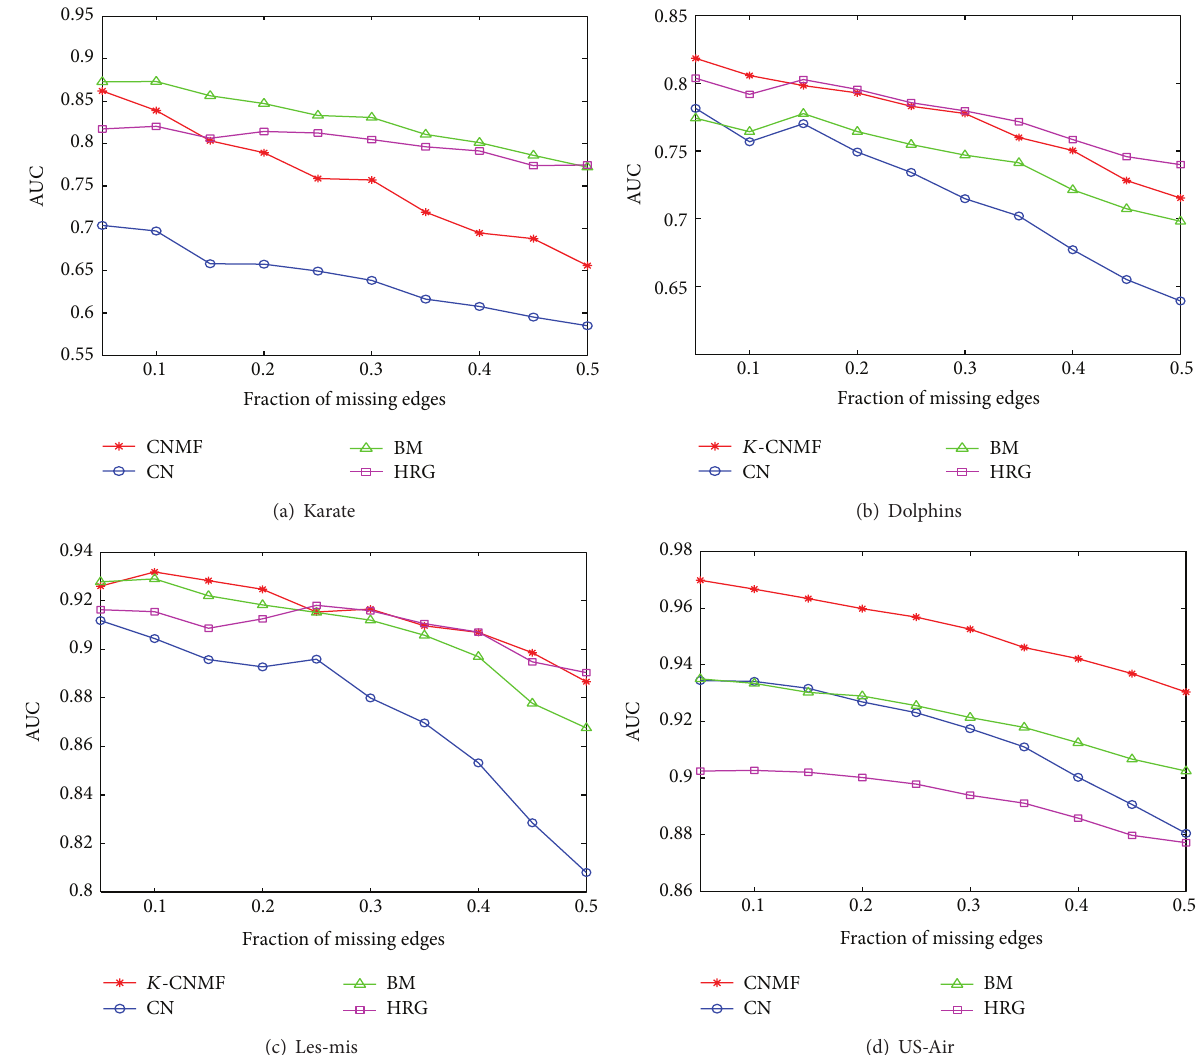
Figure 3: Comparison of 𝐾 -CNMF with CN, BM, and